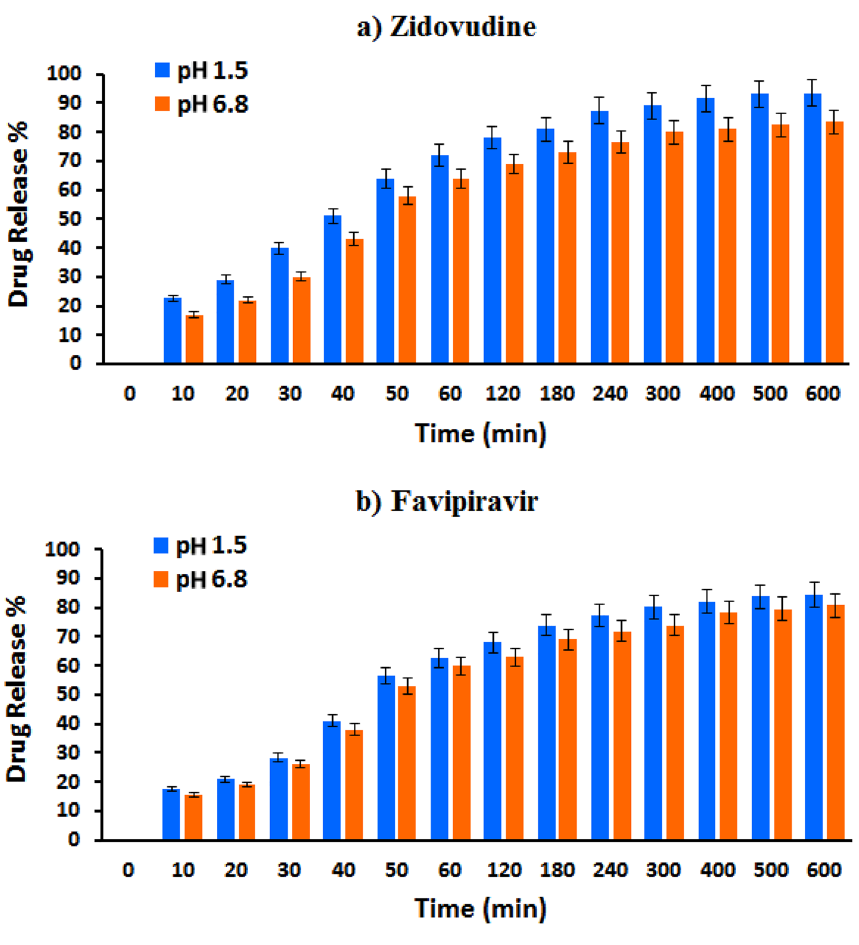
Figure 11. Drug release study of Fe 3 O 4 @SiO 2 @TAD-G3/Drug in simulated gastric fluid (SGF, pH 1.5) and simulated intestinal fluid (SIF, pH 6.8) for ( a ) Zidovudine, and ( b ) Favipiravir as model drugs.